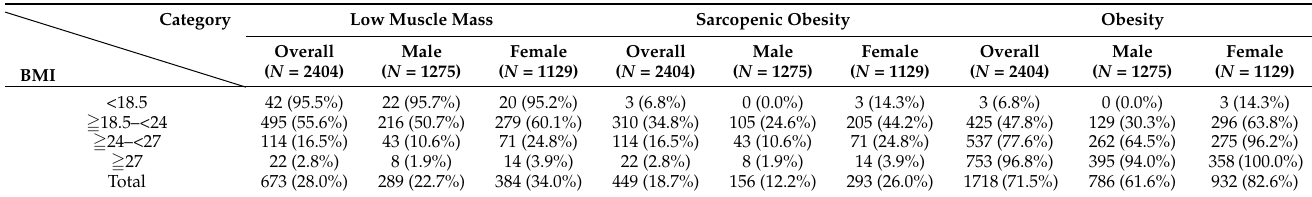
Figure 1. Obesity prevalence. Table 3. Prevalence of body composition anomalies in different BMI groups.